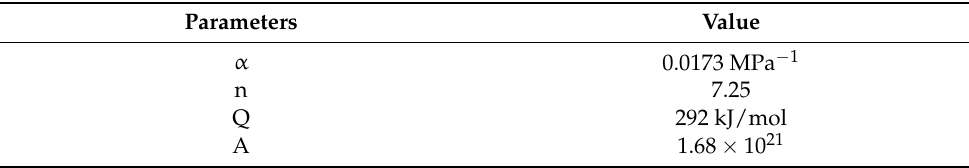
Table 3. Values of constants in the Sellars–Tegart equation for predicting the flow